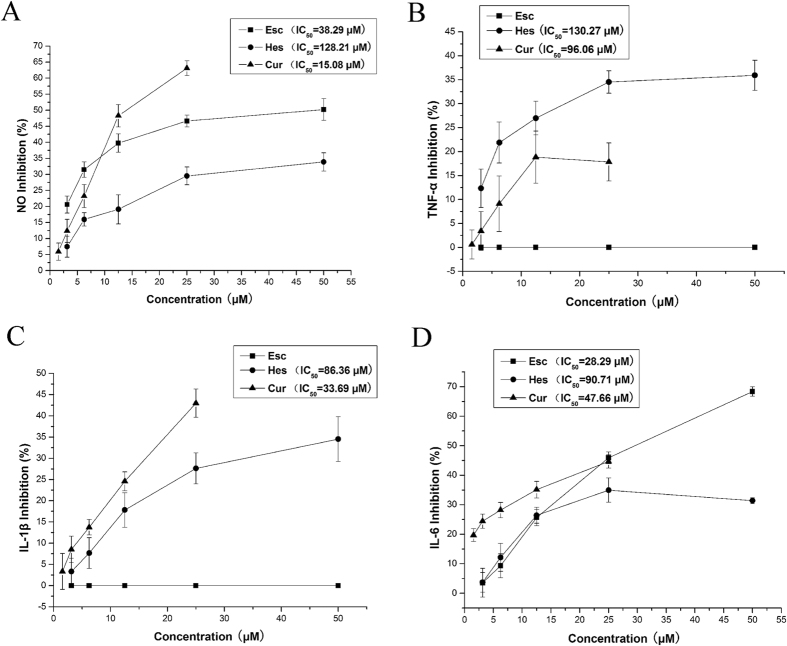
Effect of principal constituents from BE-IS on LPS-induced the production of NO and cytokines.Drugs were dissolved in DMSO and diluted in DMEM to a final value of DMSO <0.1%. All values are presented as the mean ± S.E. and are the result of three independent experiments.